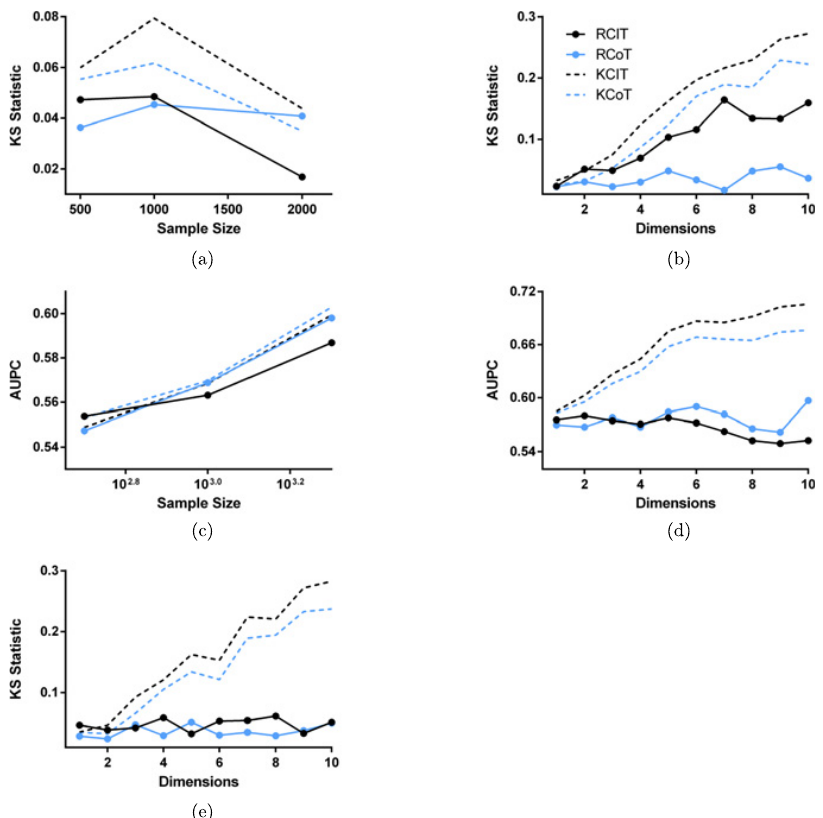
Figure 5: Results comparing against KCoT. Sub-figures (a) and (b) correspond to the KS-statistic values as a function of sample size and dimensions, respectively. Notice that RCIT and RCoT have progressively smaller KS-statistic values than both KCIT and KCoT with increasing dimensions. Next, sub-figures (c) and (d) correspond to the AUPC values also as a function of sample size and dimensions, respectively. KCIT and KCoT claim the largest AUPC values because both tests fail to control the Type I error rate well, as summarized by the large KS-statistic values in sub-figure (e) obtained after permuting the values of X .